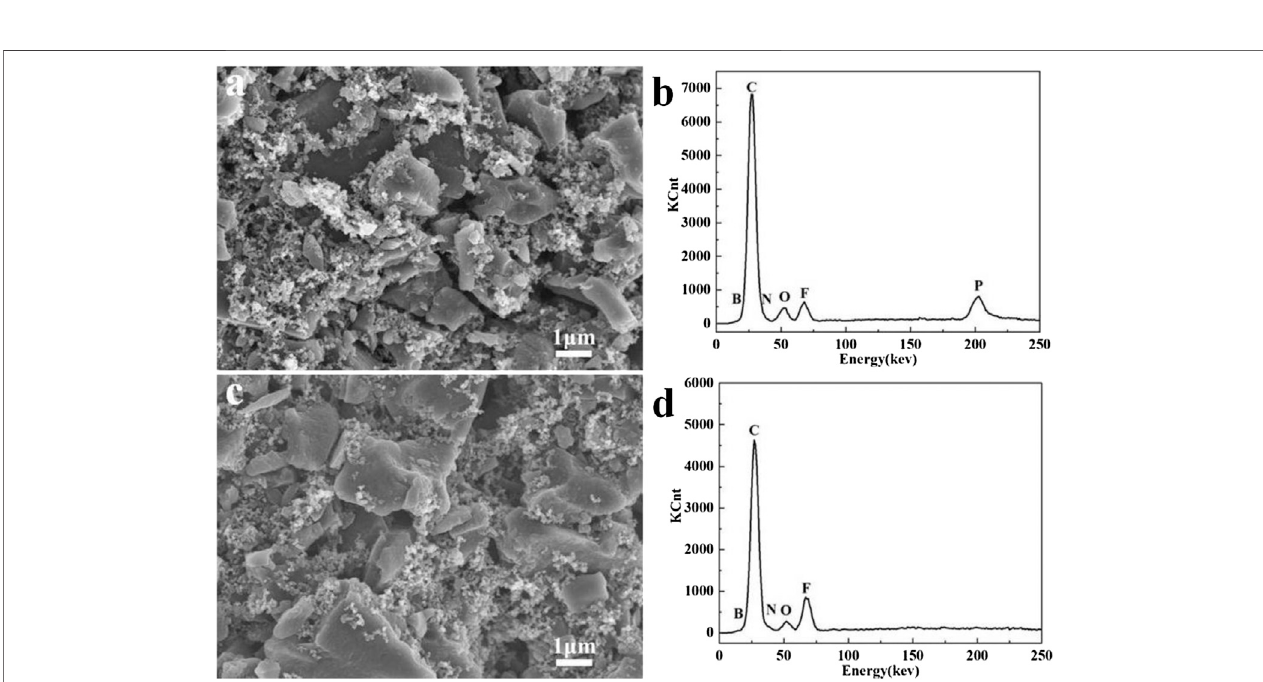
FIGURE 9 | (A,C) SEM images and (B,D) EDS spectra of the cycled carbon electrode in (A,B) EMI-BF 4 /LiPF 6 /PC/DMC and (C,D) EMI-BF 4 .